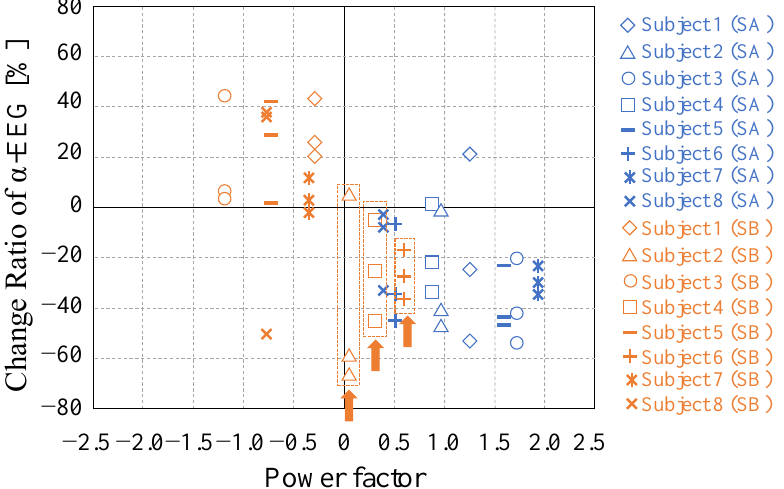
Figure 12. Examples of the time-transient change rate of α -EEG of ( a ) one subject indicated by orange triangles (Subject 2, Figure 9) categorized into both Group-2 and -4 with murmuring river sound, ( b ) another subject indicated by orange squares (Subject 4, Figure 9) categorized into both Group-2 and -4 with murmuring river sound and ( c ) another subject indicated by orange plus signs (Subject 6, Figure 9) categorized into only Group-4 with murmuring river sound, respectively. Note that in these figures the three trials in the experiment are indicated as three lines. In the case of subject in ( c ), all three lines indicate decreased α-EEG, while in the cases of ( a , b ), one line indicates increased α-EEG compared to the other two lines, indicating decreased α-EEG.